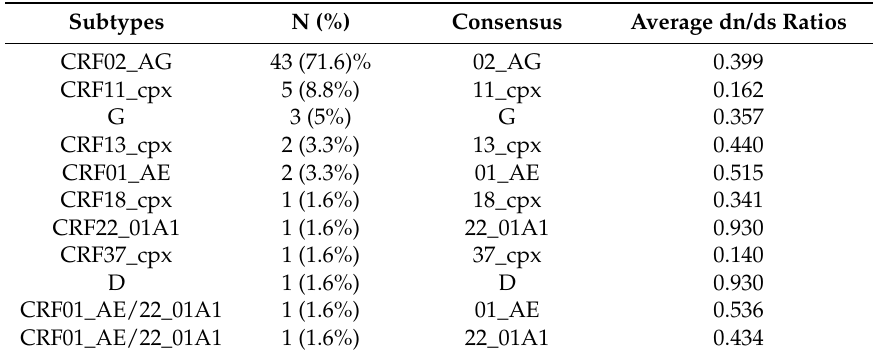
Table 3. Tat exon-1 subtypes dn/ds